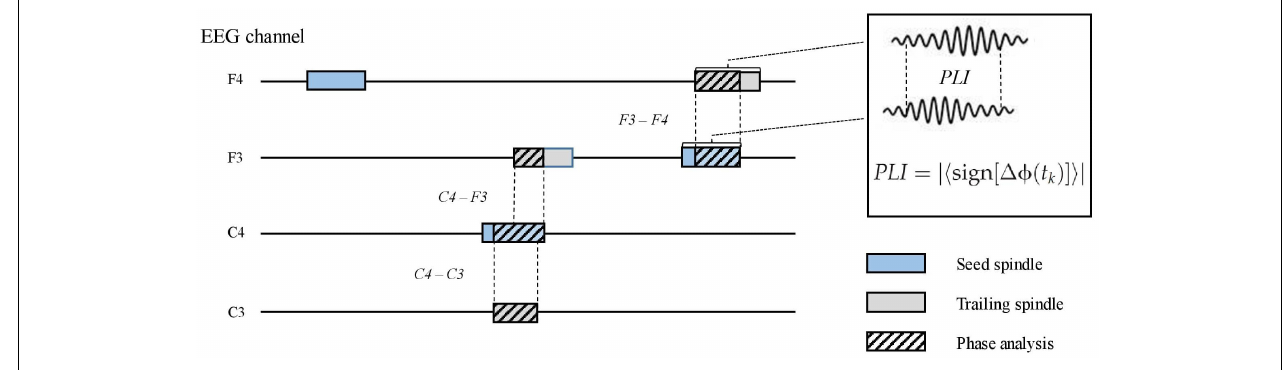
FIGURE 2 | A schematic picture of parametrizing inter-spindle synchrony. Seed spindles (light blue) may be overlapped by one or more spindles in other electroencephalography channels (trailing spindles, light gray). Phase lag index (PLI) between the seed and trailing spindles was calculated (striped pattern) if the overlap was equal or higher than 0.3 s. Sign, signum function; (cid:49)(cid:56) , phase difference; t k , samples across the overlapping signal.